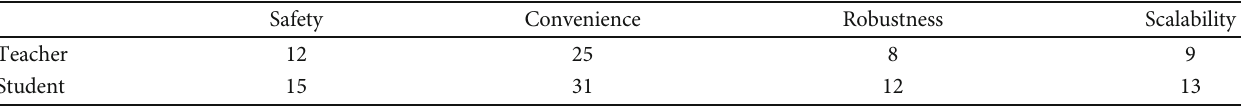
Figure 3: Comparative analysis of Taekwondo teaching. Table 5: Performance analysis of Taekwondo teaching system in colleges and universities based on D M